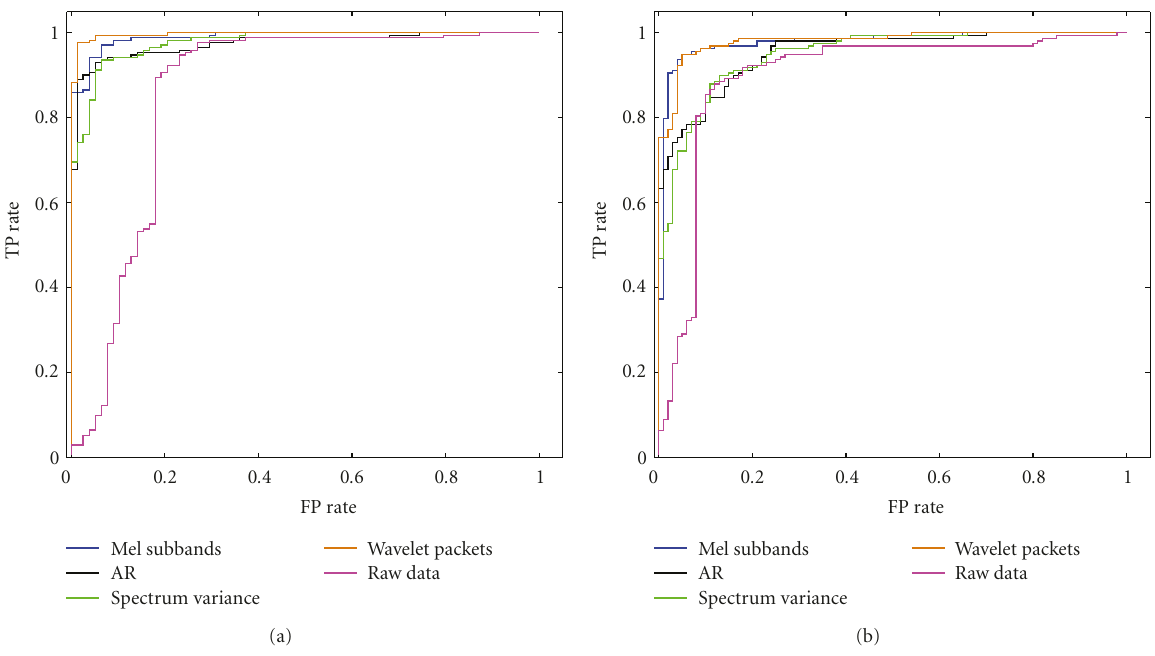
Figure 10: The training classification performance of di ff erent feature sets on the dataset SR1 (a) and SR2 (b). The best performance was obtained with WP approach. The performance of the raw AE data was quite poor compared to other methods.